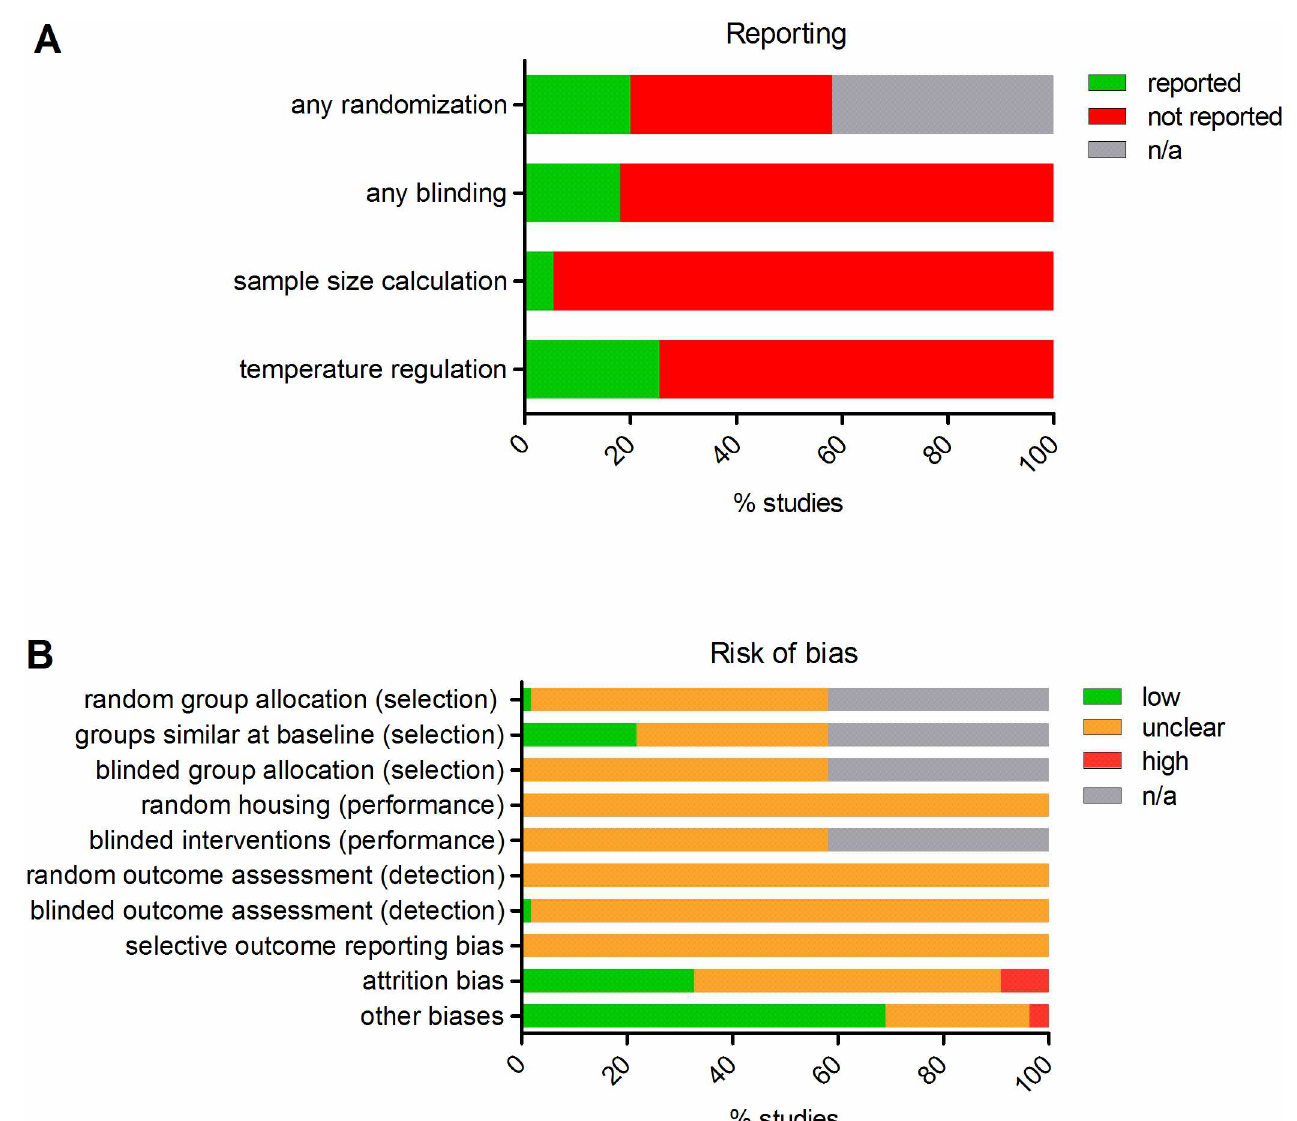
Fig 2. Risk of bias and quality assessment. Poor reporting of key study quality indicators ( A ) resulted in an unclear risk of bias for most types of bias ( B ). In some studies, unexplaineddrop-outs, and the absence of a Veress needlein the control group, led to a high risk of respectively attrition (item #9) and other biases (item #10). n/a = reportingof randomization (panel A) and items on selectionbias (#1–3) and blindingof the intervention (item #5; panel B) were not applicableto Δ